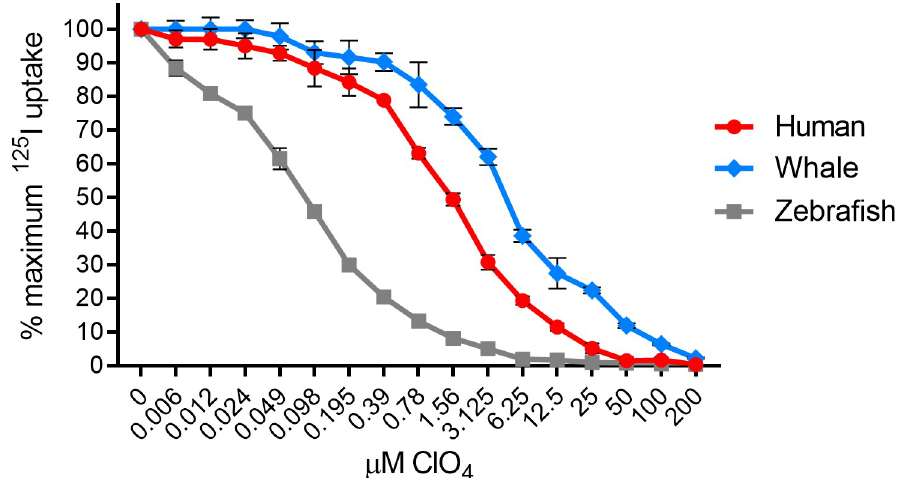
Fig 5. Perchlorate IC 50 determination for HA-human-, HA- minke whale-, and HA-zebrafish NIS. Lentivirally transduced HeLa cells were incubated with 125 I - with increasing concentration of perchlorate (ClO 4- ) for 50 minutes prior to two washes with cold buffer. IC 50 values were determined via non-linear regression using the equation setting: {inhibitor} vs. normalized response—variable slope–inhibition in Prism 8. Human NIS ClO 4- IC 50 = 1.566 μ M. Minke whale NIS ClO 4- IC 50 = 4.566 μ M. Zebrafish NIS ClO 4- IC 50 = 0.081 μ M. Values are average of triplicate assays with standard